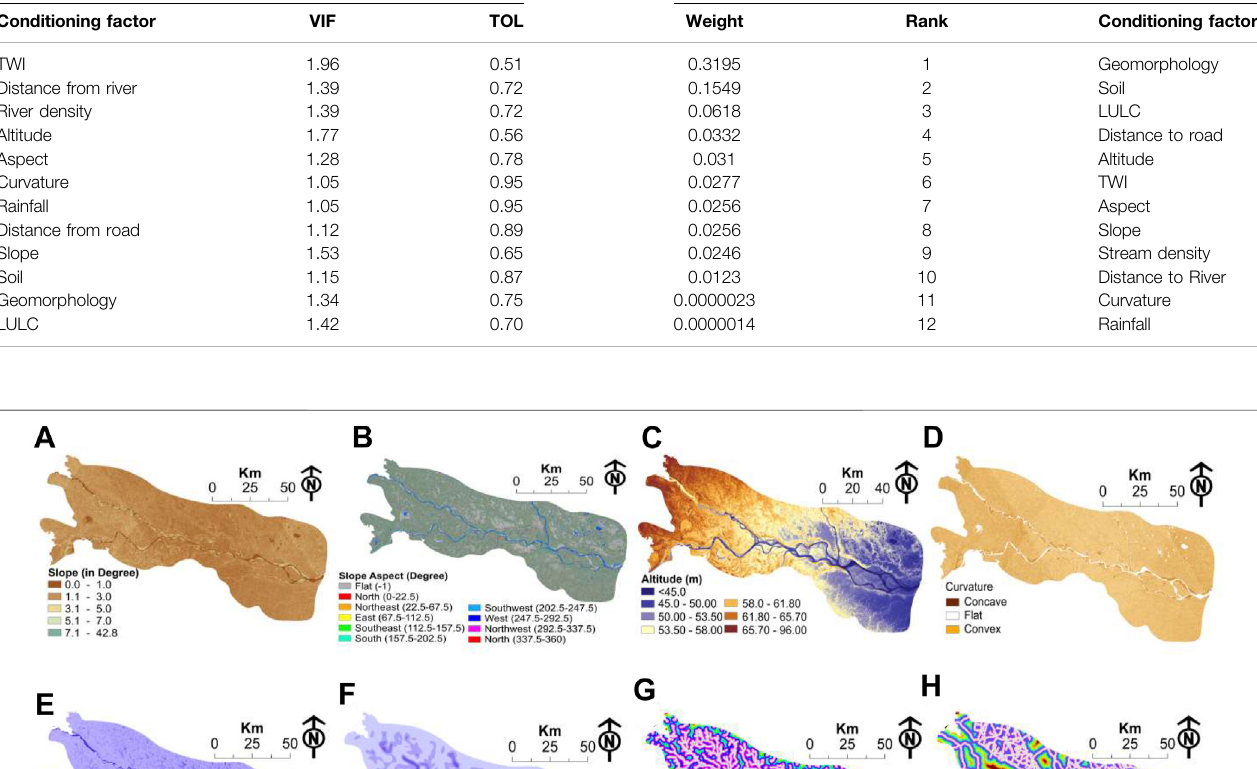
Frontiers in Earth Science |